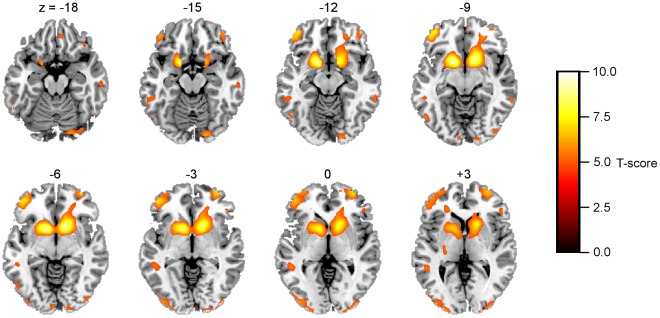
Statistical parametric one-sample t-maps of the Gain-Loss contrast for all groups combined (n = 89 subjects) that delineates the “Reward network”.Axial slices are labeled from z  = −18 mm to z  = +3 mm in steps of 3 mm. The threshold was set at p<0.05, FWE whole-brain corrected.